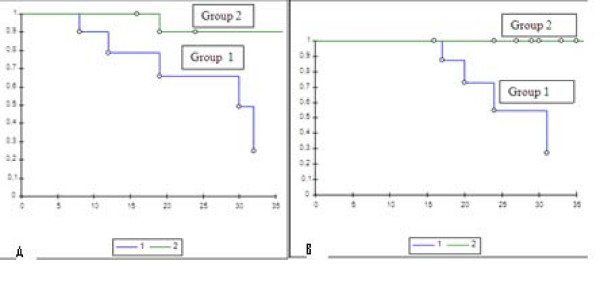
Kaplan-Meier survival curve in relation to post-chemotherapy VEGF expression in viable tumor cells. Disease-free (A) and overall (B) survival of patients affected by osteosarcoma. Y-axis = Survival proportion; X-axis = follow up in months; group 1 = post-chemotherapy increased VEGF expression; group 2 = post-chemotherapy unchanged VEGF expression.